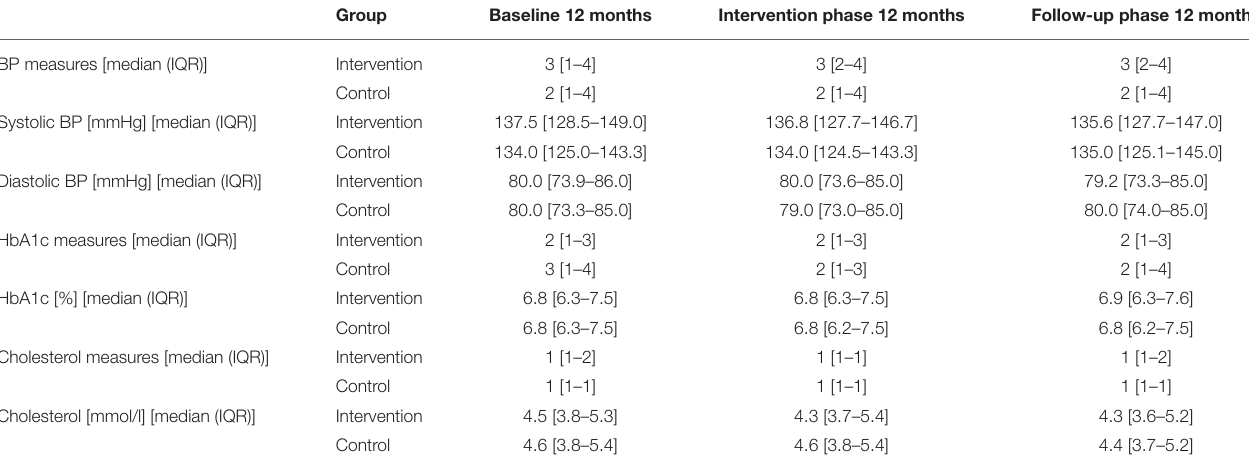
TABLE 2 | Numbers of measurements per patient, and clinical values of BP, HbA1c, and cholesterol over the entire study